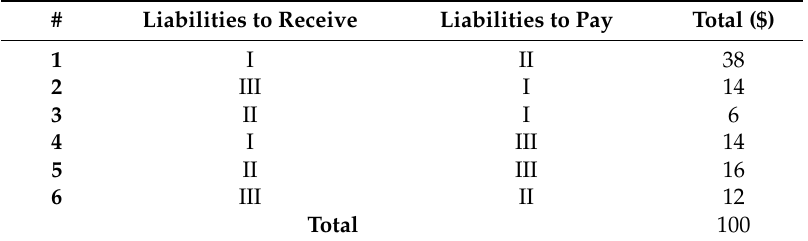
Table 3. The Ledger of the total liabilities for players I, II, III